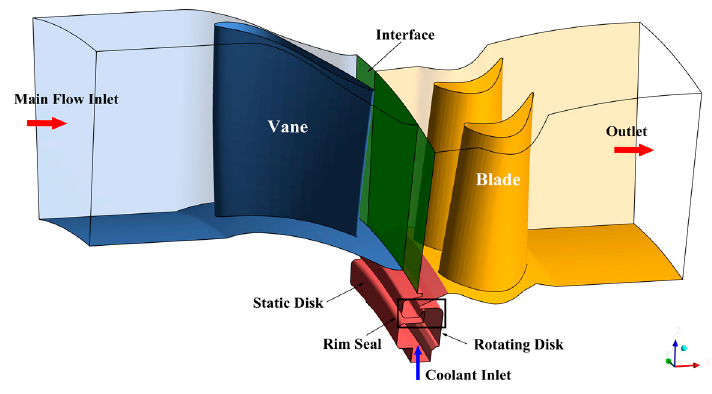
Figure 1. Computational domain of turbine rim